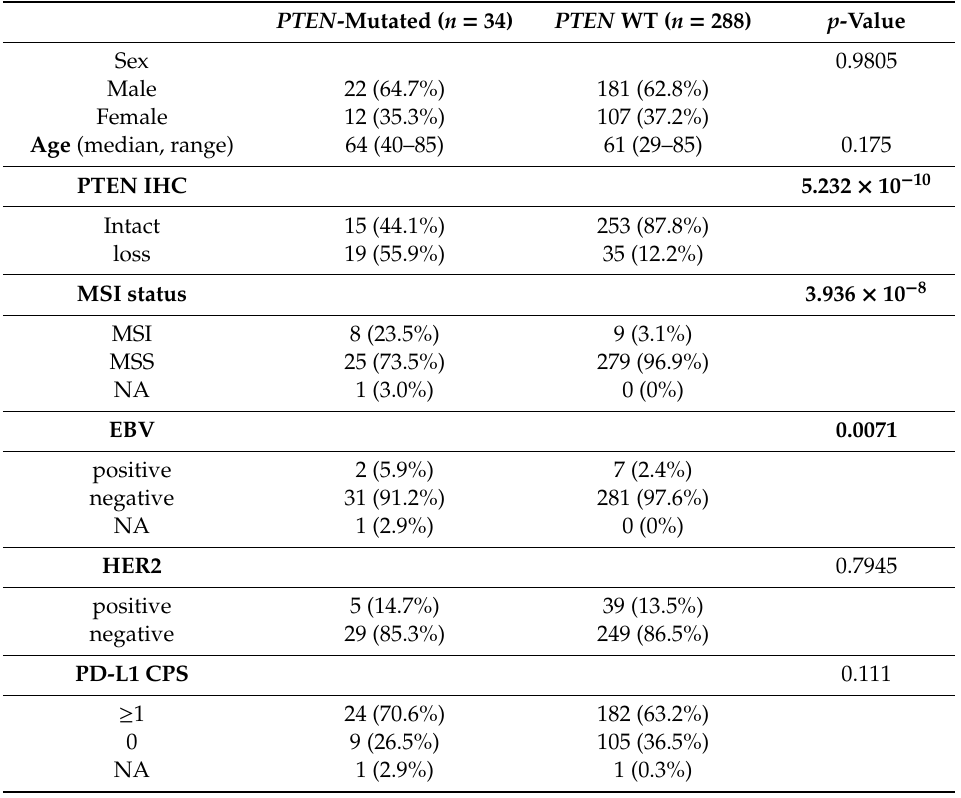
Table 2. Comparison of clinicopathologic characteristics between phosphatase and tensin homolog ( PTEN )-mutated gastric carcinomas and PTEN wild-type gastric carcinomas.